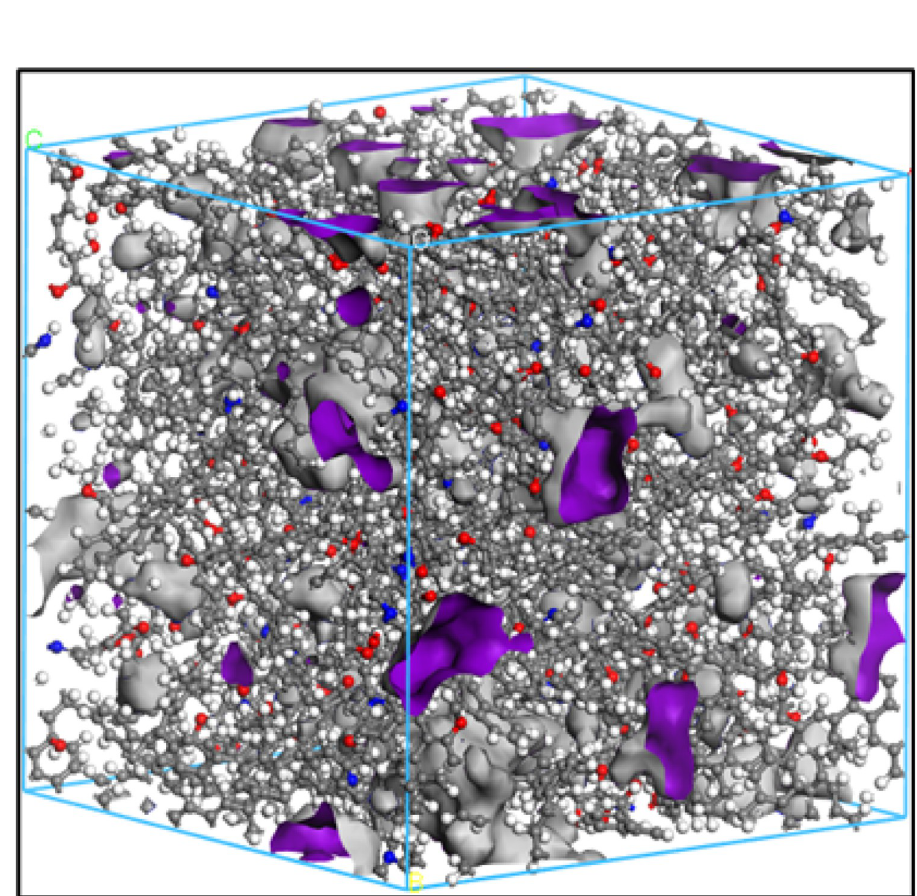
Fig 12. Cellular model of the molecular structure of anthracite.